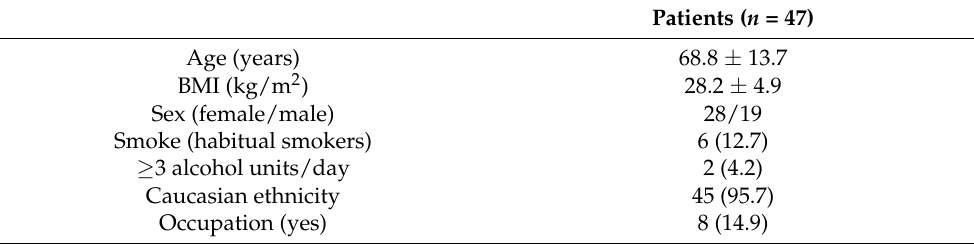
Table 1. Anamnestic and demographical characteristics of the study